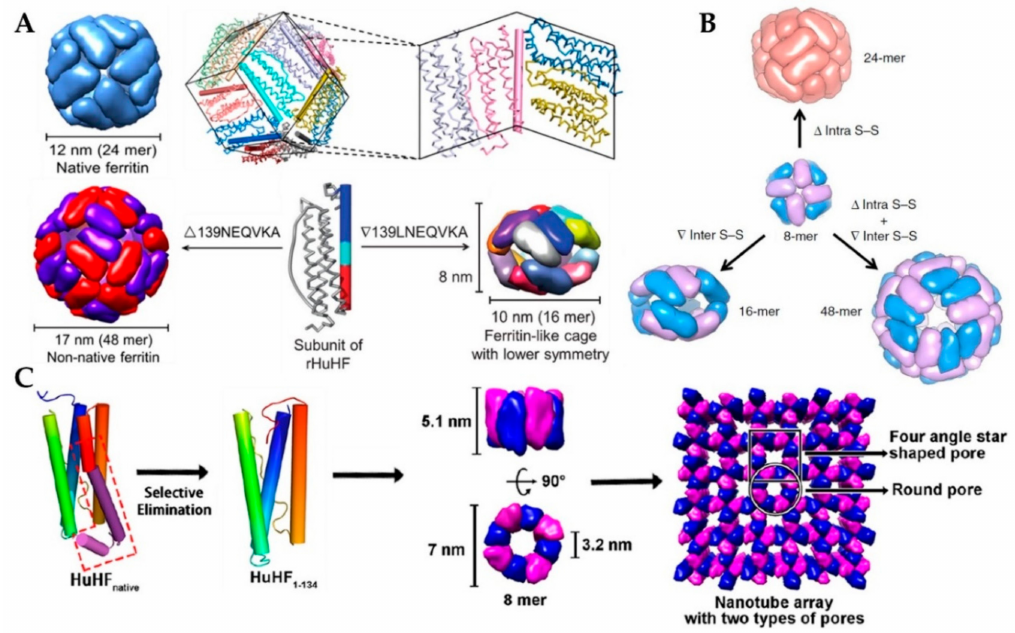
Figure 3. ( A ) Schematic representation of conversion of native human ferritin into its 48-mer and 16-mer analogues (Reproduced with permission from [48,49], ACS Nano and Angew. Chem. Int. Ed. , 2016, respectively.). ( B ) Schematic representation of the conversions from 8-mer bowl-like proteins to protein nanocages with di ff erent sizes and geometries (24-mer, 16-mer, and 48-mer) (Reproduced with permission from [50], Nat. Commun., 2019). ( C ) Conversion from 24-mer protein nanocage